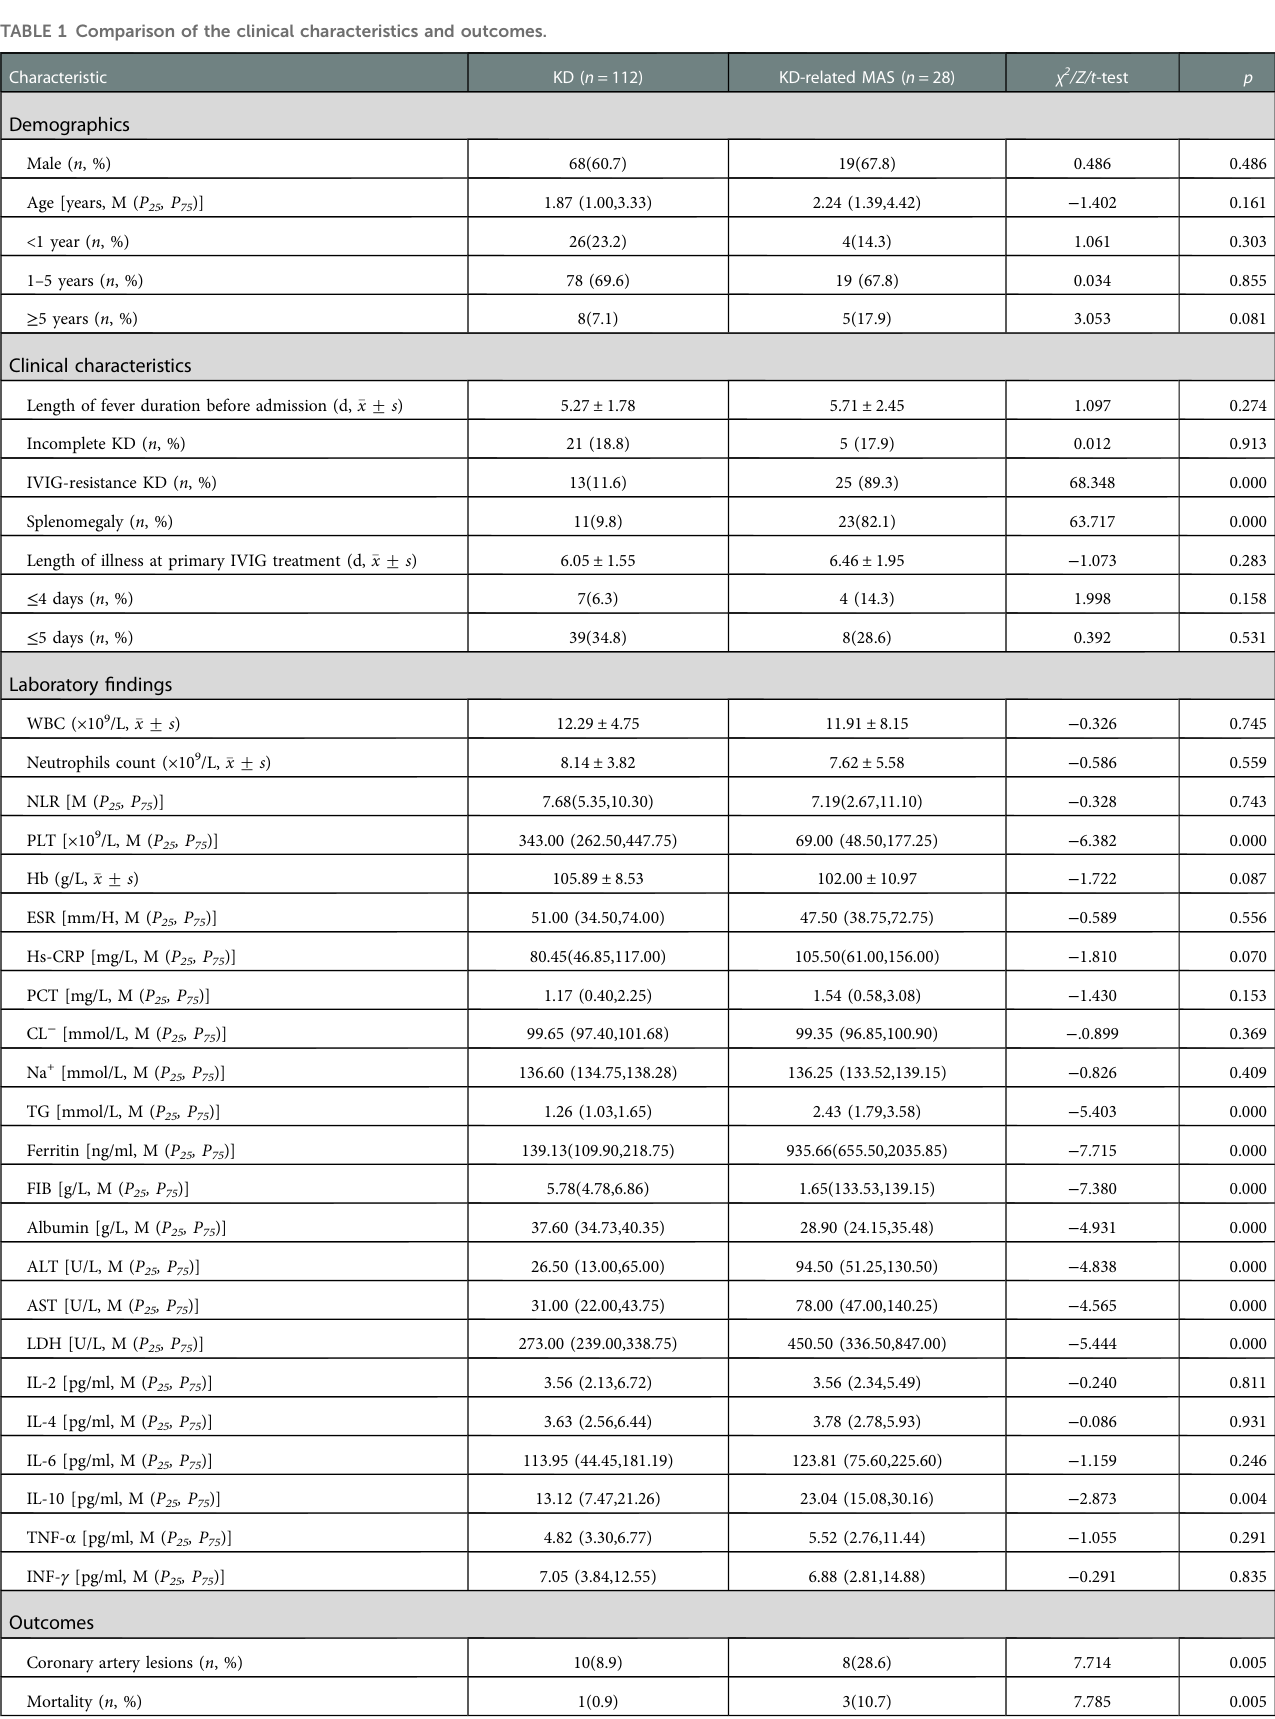
TABLE 1 Comparison of the clinical characteristics and